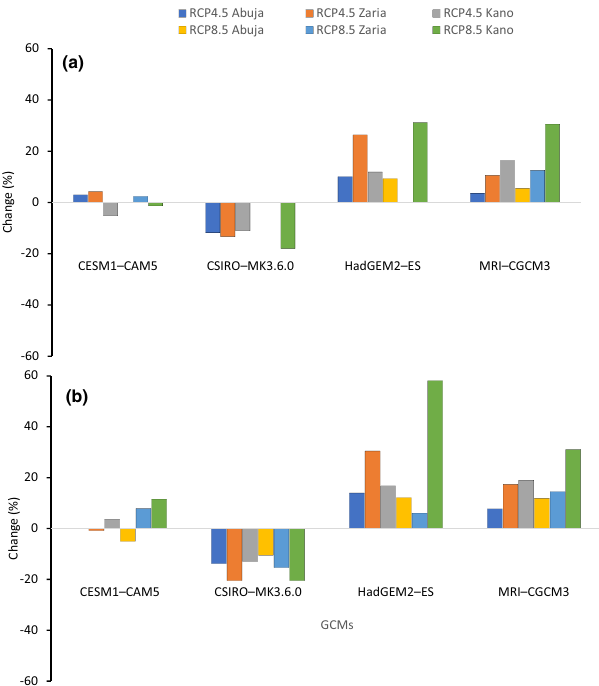
Figure 6. Rainfall change in percentage from the baseline period for four general circulation models under RCP4.5 and RCP8.5 at Abuja, Zaria and Kano in Nigeria for mid-century ( a ) and end-of-century ( b ) periods.